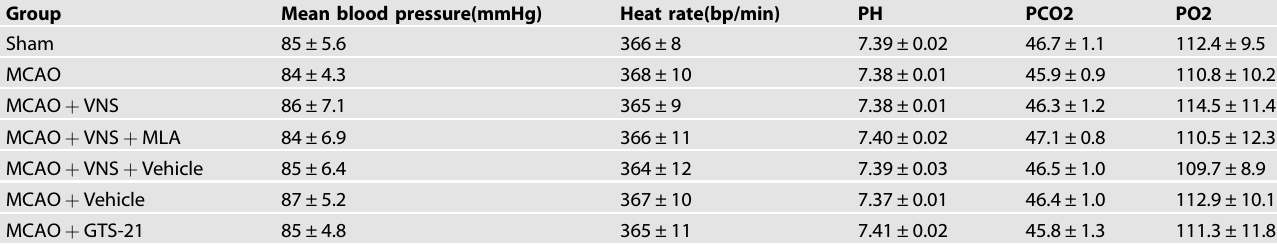
Table 1. The physiological parameters during the experiment (all data are shown as the mean ±